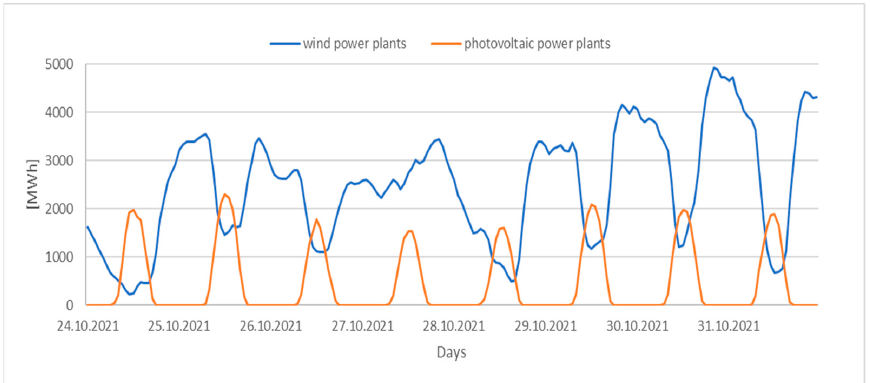
Figure 10. Power generation by photovoltaic and wind power plants in Poland on selected days in October 2021 (own elaboration based on data from PSE S.A.).